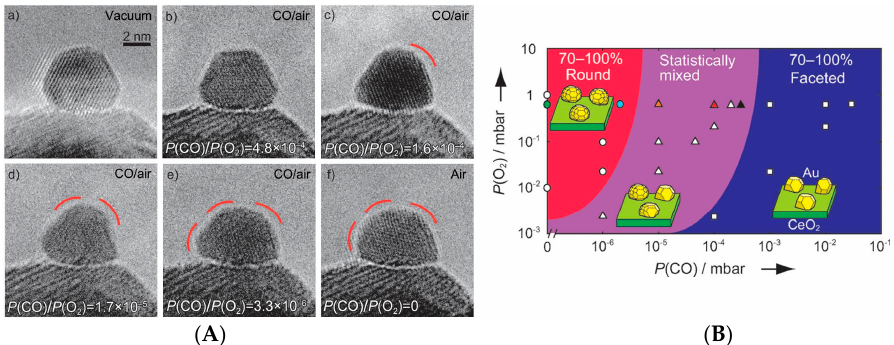
Figure 22. Study of the morphology of active Au nanoparticles: ( A ) Morphological change of an Au nanoparticle when the pressure ratio CO/O 2 is decreased; ( B ) Morphology diagram representing the dependence of the morphology of Au nanoparticles on the partial pressure of CO and O 2 , with mostly round-shaped particles in oxidising environment and facetted particles in reducing environment.